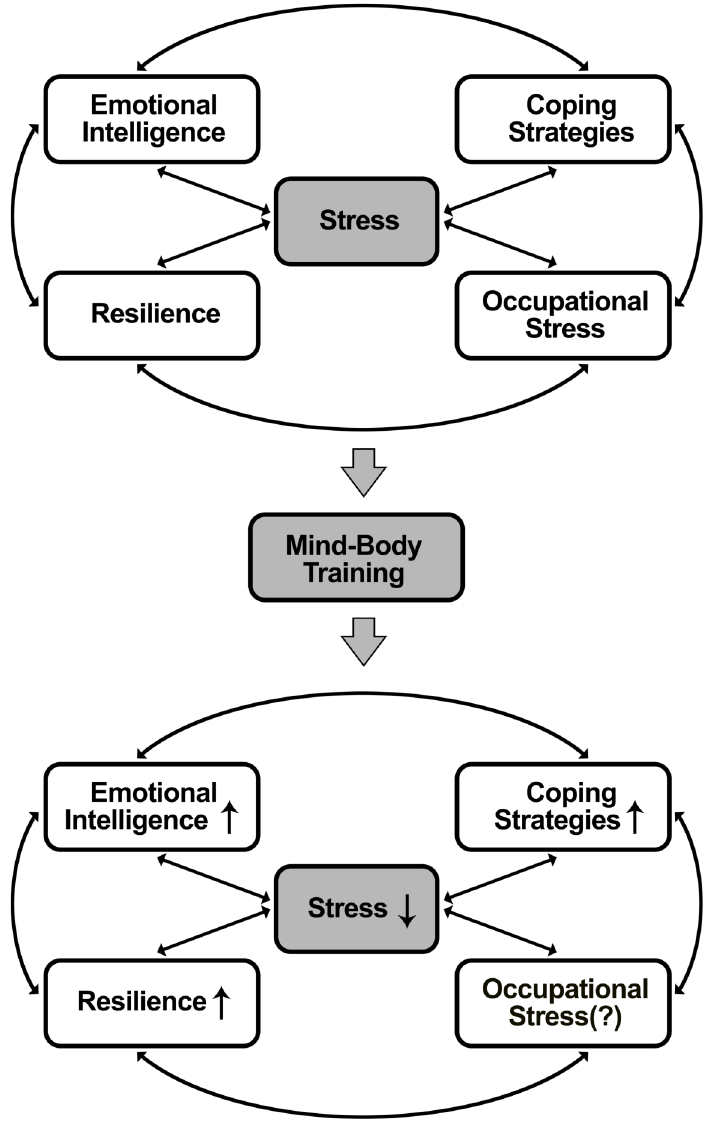
Fig 1. Proposed model of the effects of MBT on perceived stress, coping strategies, emotional intelligence, and resilience.